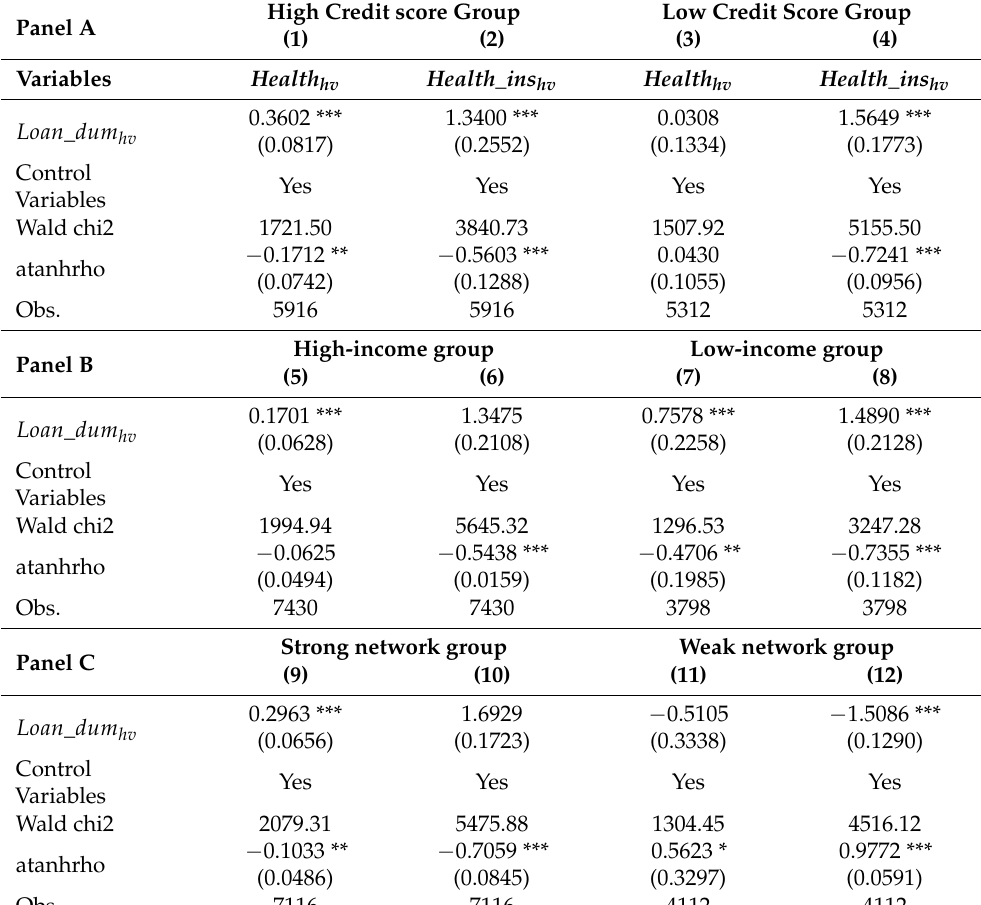
Table 6. Heterogeneous effects of social networks and microcredit on